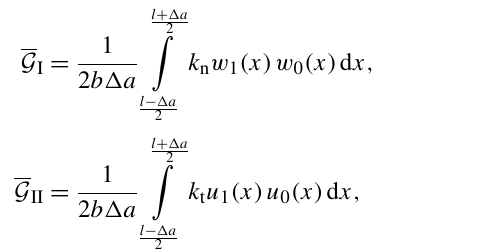
Figure 5. Finite element model used for validation. Discretization of a snowpack with slab and weak layer. Cracks are introduced by removing all weak-layer elements. Skier loads are applied as ver- tical concentrated forces. Here, the case of a propagation saw test is shown as an example. The rigid base below the weak layer has a Young modulus of E base = 10 12